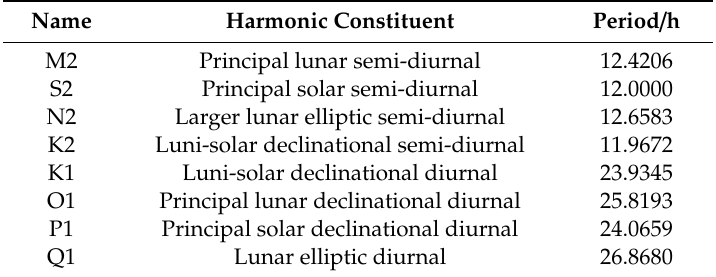
Table 1. The periods of the eight semidiurnal and diurnal tidal constituents.